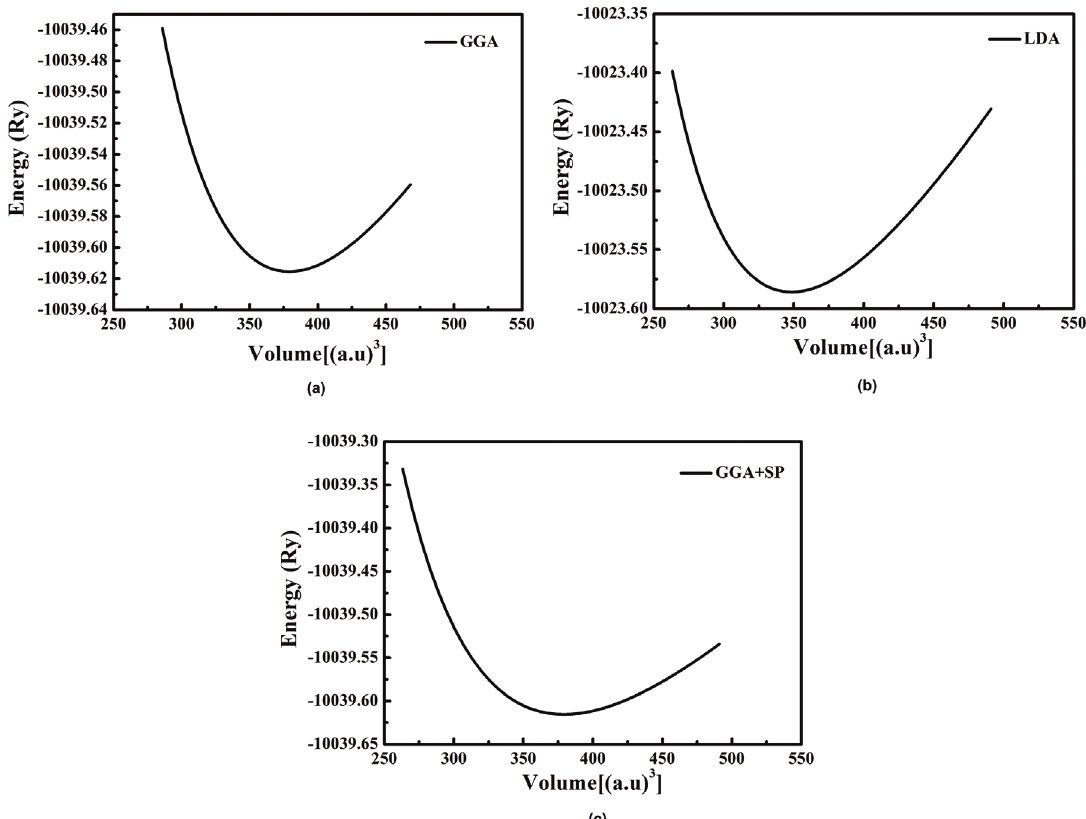
N. by (a) GGA, (b) LDA and (c) GGA+SP 3